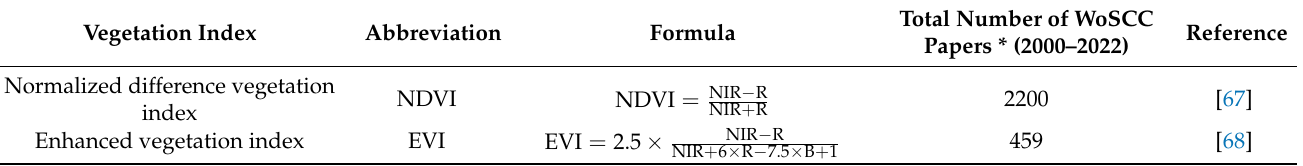
Table 1. Eight major vegetation indices based on multispectral sensors with the highest total number of appearances in WoSCC papers since